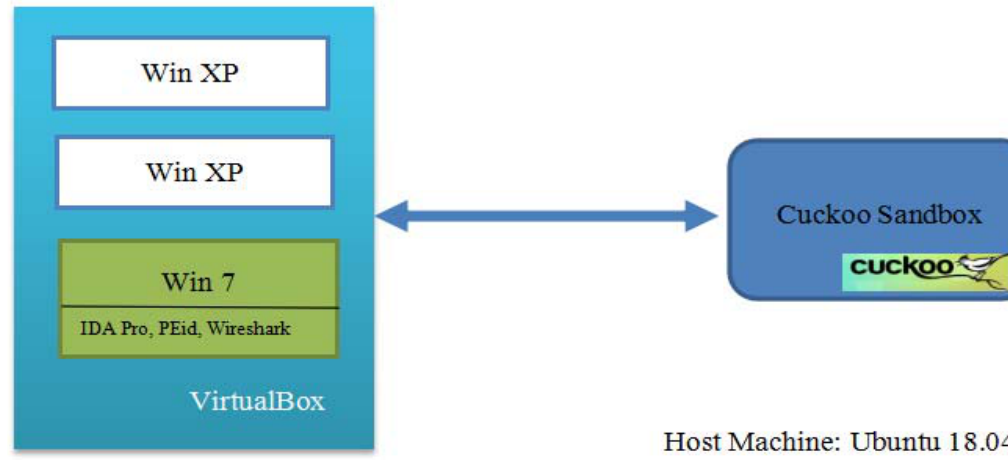
Figure 4. The main component of the experimental environment.